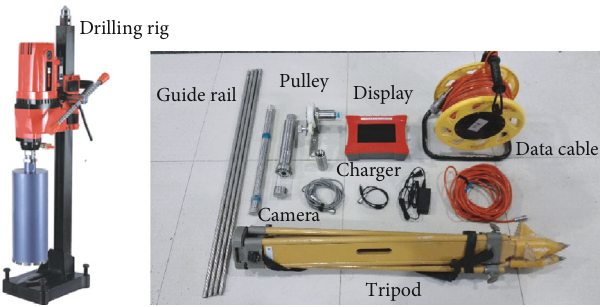
Figure 18: Bench drill and drilling imaging